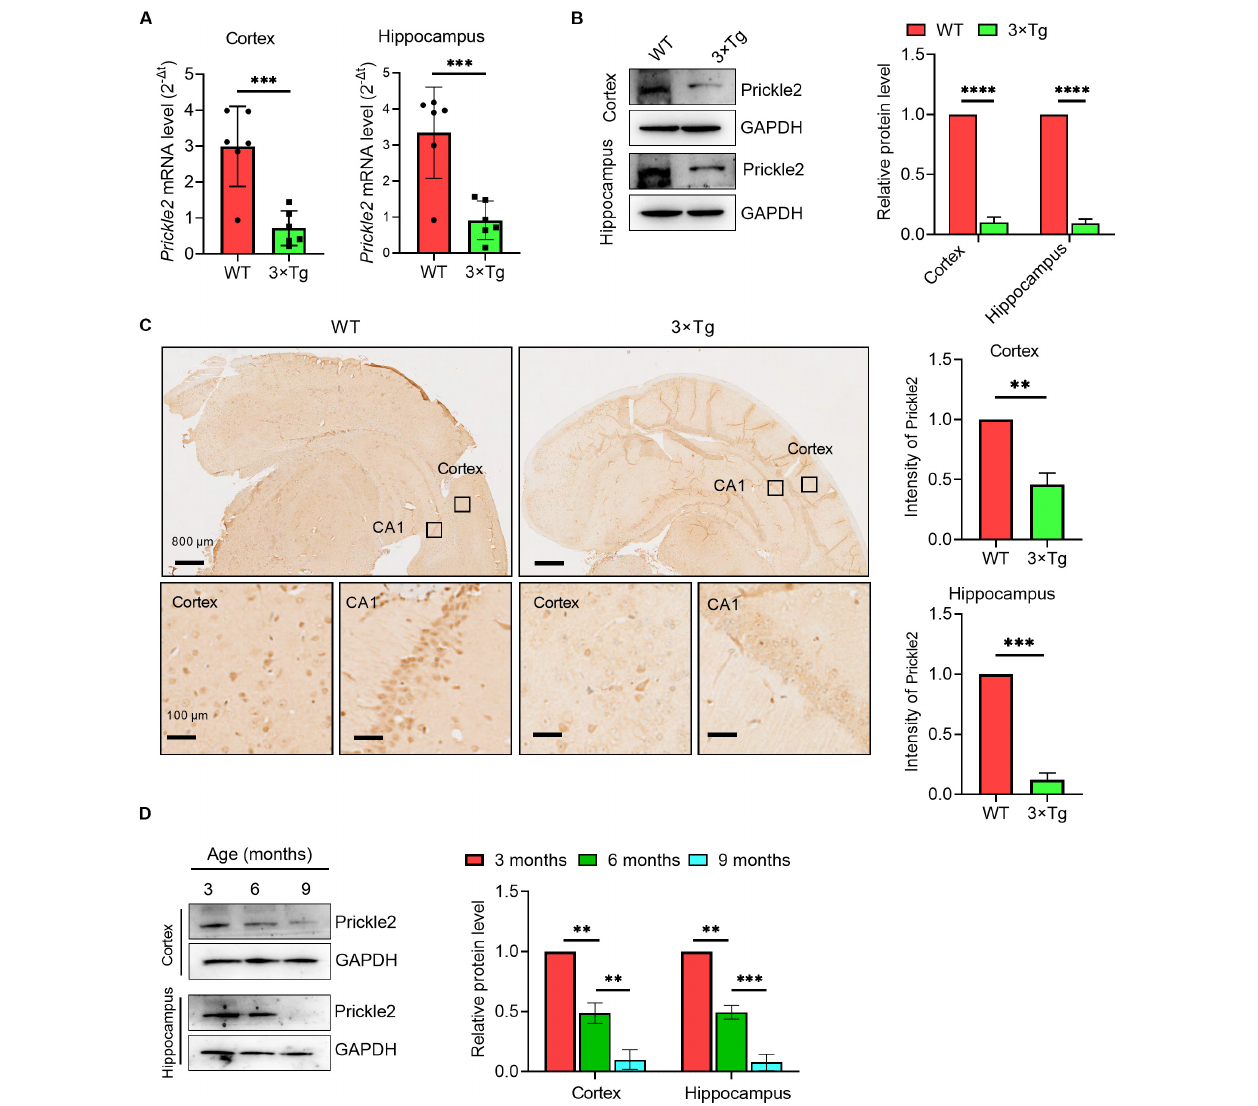
FIGURE 1 | Prickle2 is downregulated in the brain tissues of 3 × Tg mice. (A) Prickle2 mRNA ( n = 6 per group) in the cortex and the hippocampus isolated from mouse brain. (B) Western blotting for Prickle2 in the cortex and the hippocampus isolated from mouse brain ( n = 6 per group). (C) IHC for Prickle2 in cortex and hippocampus isolated from mouse brain ( n = 6 per group). (D) Western blots in cell lysates from AD mice during aging with antibodies against Prickle2 and GAPDH, as indicated. Blotting intensities are normalized to GAPDH from AD mice at three months old of age (defined as 1.0, n = 6) (A–D) Student’s t test. ∗∗ p < 0.01; ∗∗∗ p < 0.001; ∗∗∗∗ p <